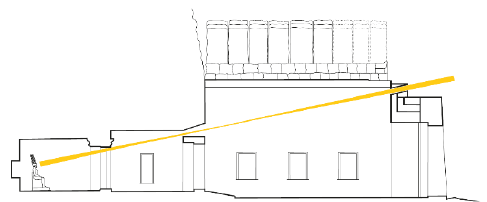
Figure 2 . Longitudinal section in Amon Re’ sanctuary depicts the luminous flux coming through the elaborated system of skylight to illuminate the cult statue. This illustration was extracted from (Pawlicki,